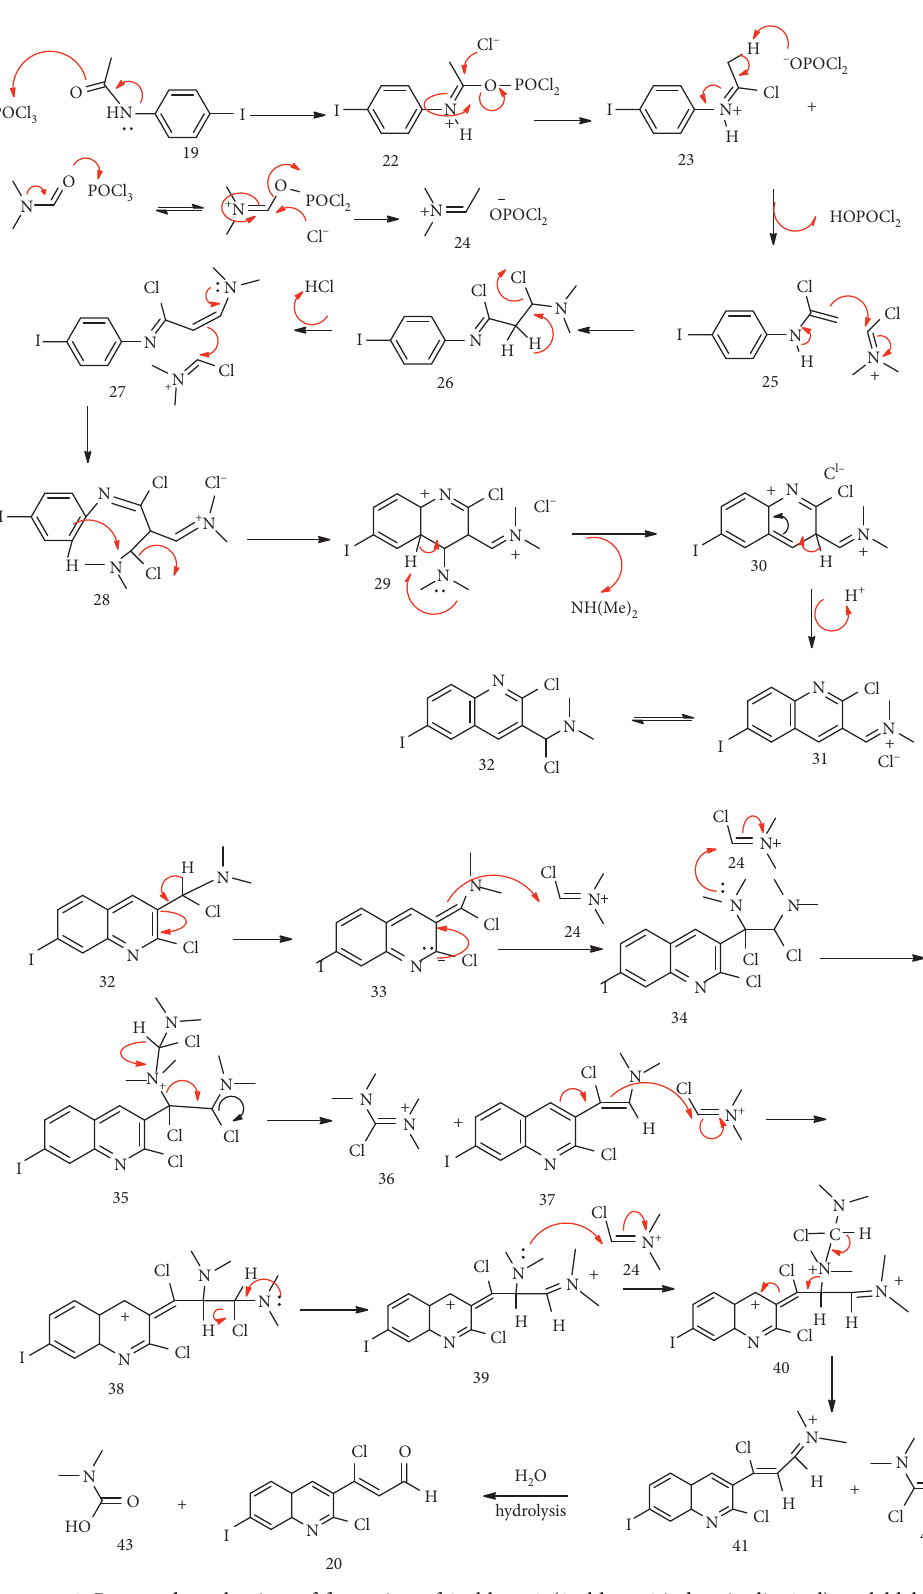
Scheme 4: Proposed mechanism of formation of